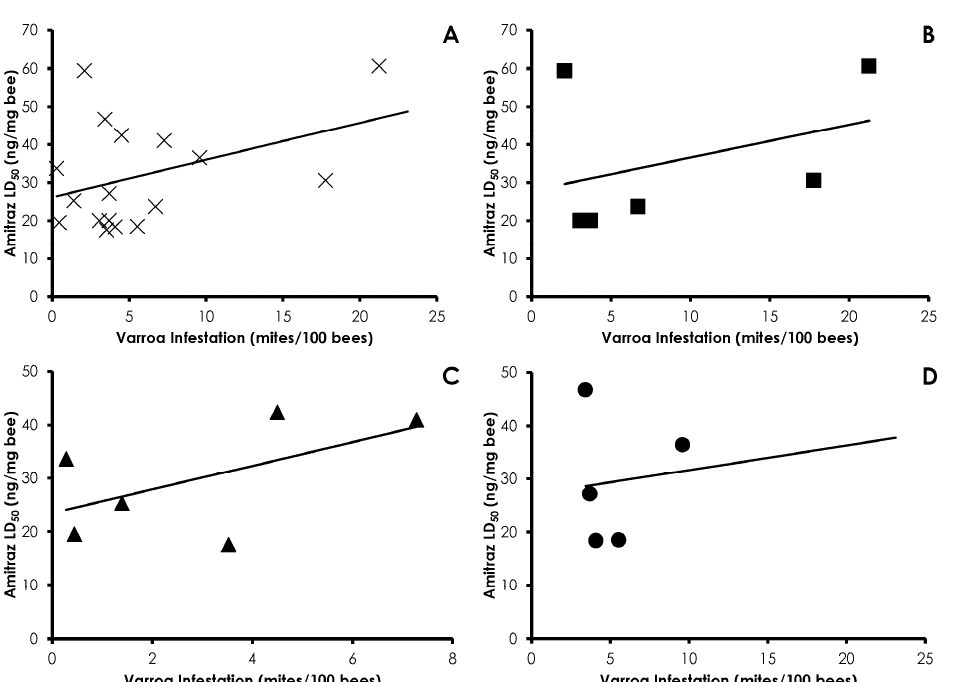
Figure 4. Influence of Varroa infestation on amitraz sensitivity in all treatments ( A ); Control ( B ); Amitraz ( C ); and IPM ( D ) treatment groups. There was no significant effect of Varroa infestation on amitraz sensitivity in any instance.